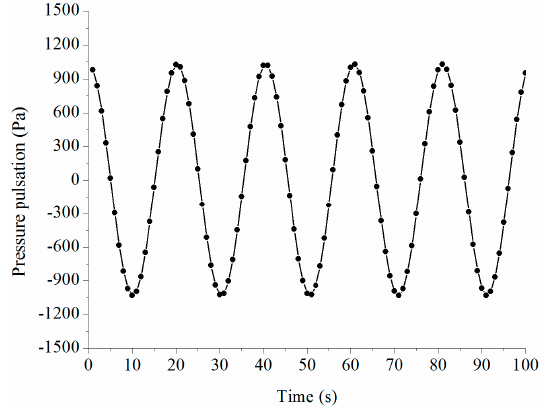
Figure 5. Pressure pulsation at the first 100 s of the elbow.